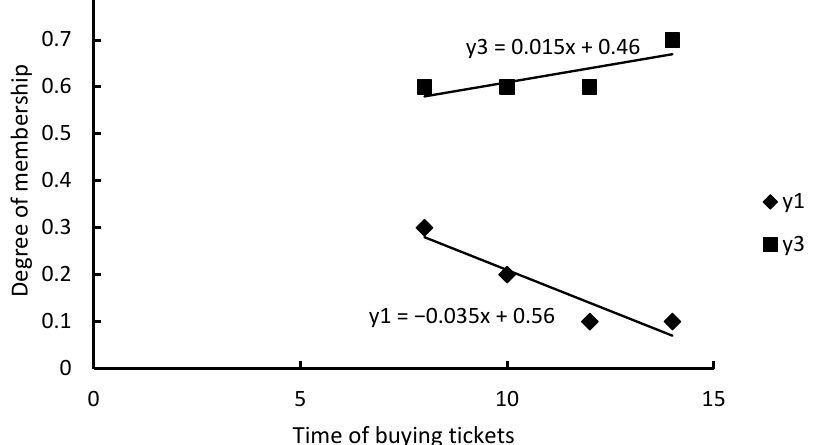
Figure A34. Single factor evaluation for the index of time of buying tickets (8–14 days before de- parture).